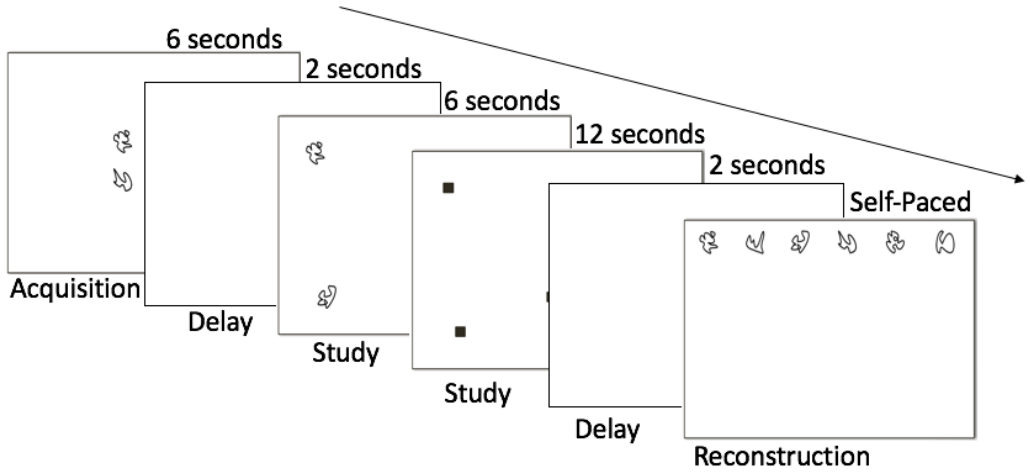
Figure 1. Spatial reconstruction task description.